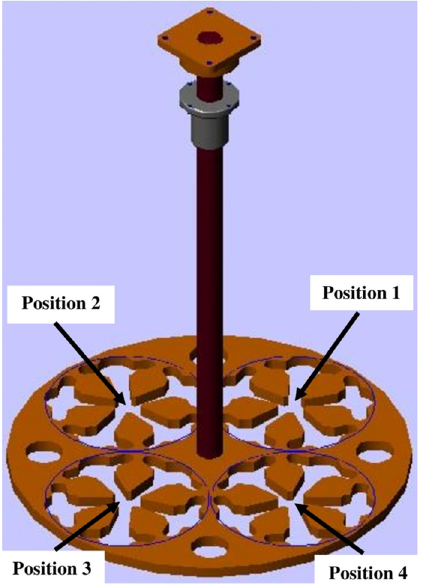
Fig. 9. The developed 4-positions mass